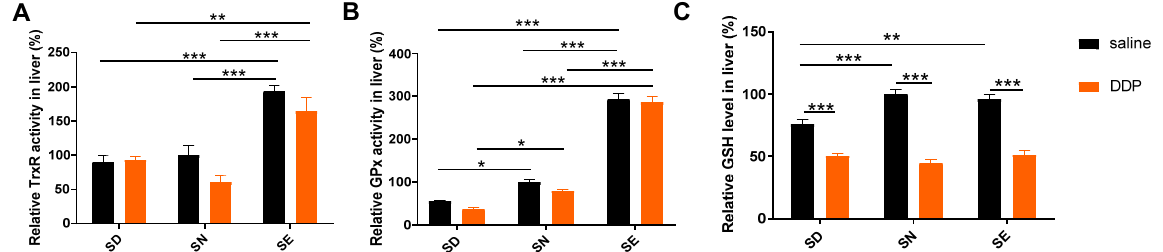
Figure 4. Selenium status affects liver TrxR and GPx activity and GSH levels after DDP treatment. ( A ) Liver TrxR activity, ( B ) GPx activity, and ( C ) GSH levels. Each sample was analyzed in triplicate. Data are normalized using the value from samples of SN saline group as control (100%) and presented as mean ± SEM; * p < 0.05; ** p < 0.01; *** p < 0.001; two-way ANOVA, n = 5–6. SD, selenium-deficient; SN, selenium-normal; SE, selenium-enriched; DDP, cisplatin.